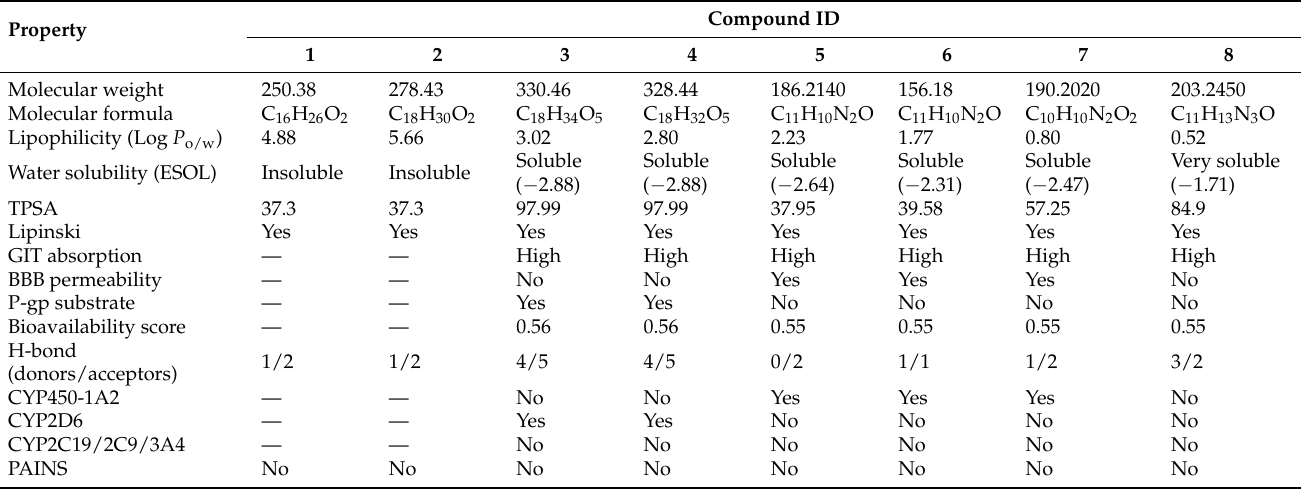
Table 5. The predictive physicochemical, pharmacokinetic, drug-likeness, and toxicity properties of isolated SI compounds ( 1 – 8 ).